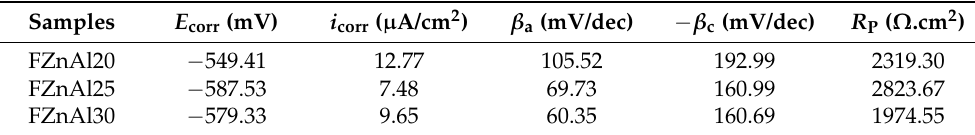
Figure 1. DC polarization curves for silicate coating containing different ZnAl alloy concentrations after immersion in NaCl (3.5 wt%) for 48 h. Table 1. Data obtained from DC polarization curves for silicate coating containing different ZnAl alloy concentrations after immersion in NaCl (3.5 wt%) for 48 h.